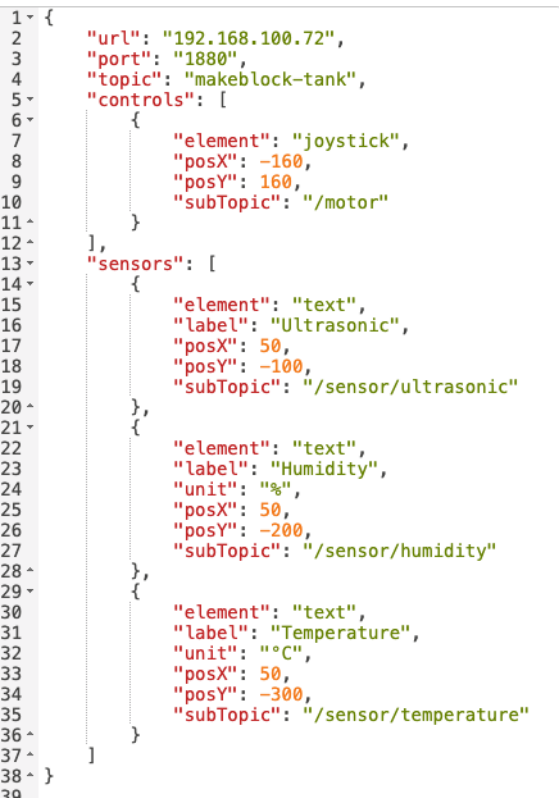
Figure 8. JSON definition scheme for mechatronic device Makeblock